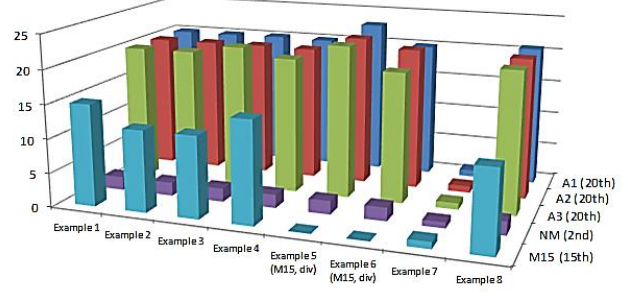
Fig. 3. Observed orders of convergence to achieve specified error tolerance in all methods for examples 1-8